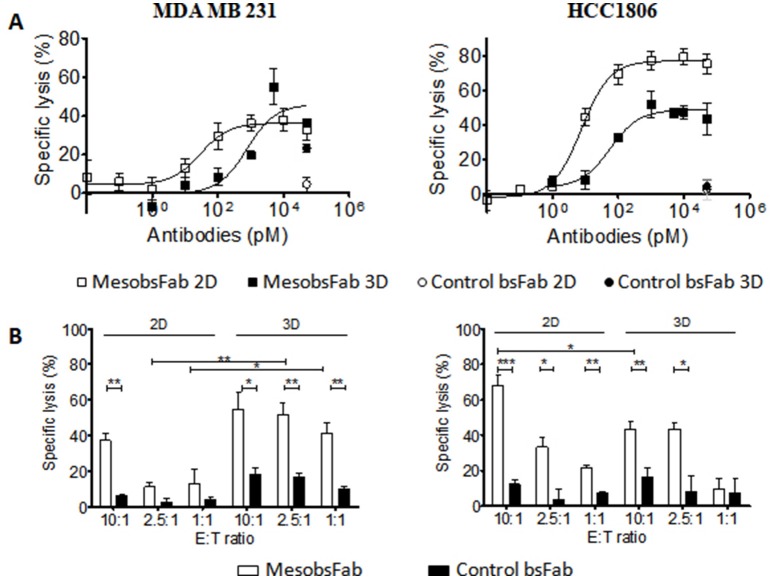
MesobsFab mediates potent in vitro ADCC activity against TNBC cell lines. (A) ADCC assays were performed on 2D and 3D cell models using serial dilutions of MesobsFab, unstimulated NK cells as effector cells and MDA MB 231 or HCC1806 as target cells (E:T ratio 10:1). Control bsFab was tested at the highest concentration (50 nM). Target cell viability was determined by CellTiter-Glo viability assay for 2D ADCC or by flow cytometry after spheroid dissociation for 3D ADCC. (B) Impact of the E:T ratios on the maximal lysis of MDA MB 231 and HCC 1806 monolayers and spheroids mediated by 5 nM, (EC90) MesobsFab or control bsFab. Data shown are mean ± SEM from 3 independent experiments (3 donors). Statistical analysis was performed by two-tailed Student's t-test. *p < 0.05; **p < 0.01; ***p < 0.001.